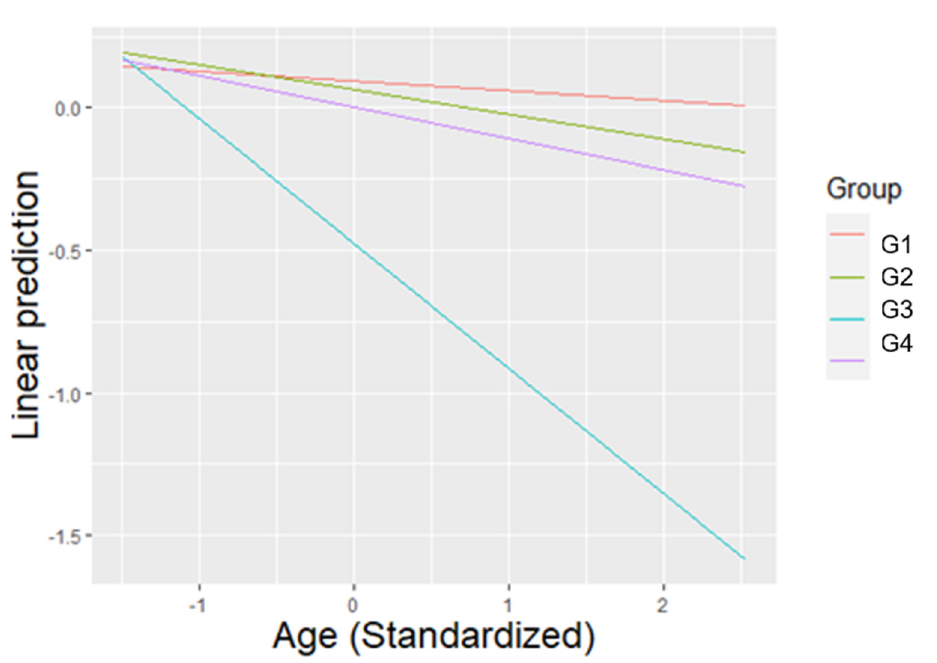
Table 6. Model structures and AIC values obtained during model selection for abnormal behaviours. Model Model Structure